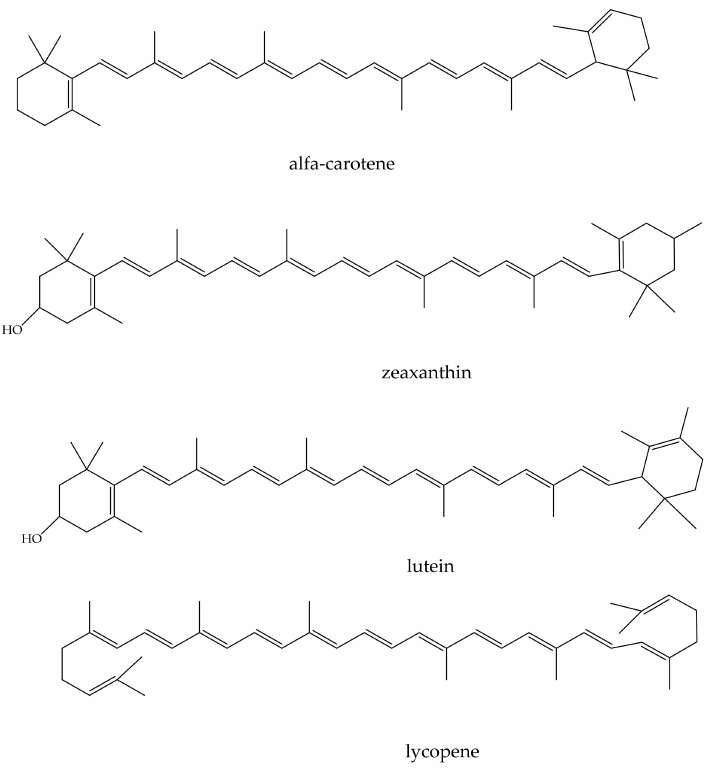
Figure 5. Structures of the most widespread